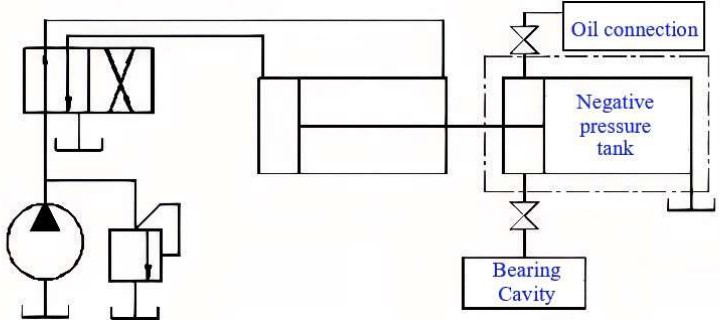
Figure 4. Working principle diagram of active waste oil recovery system.